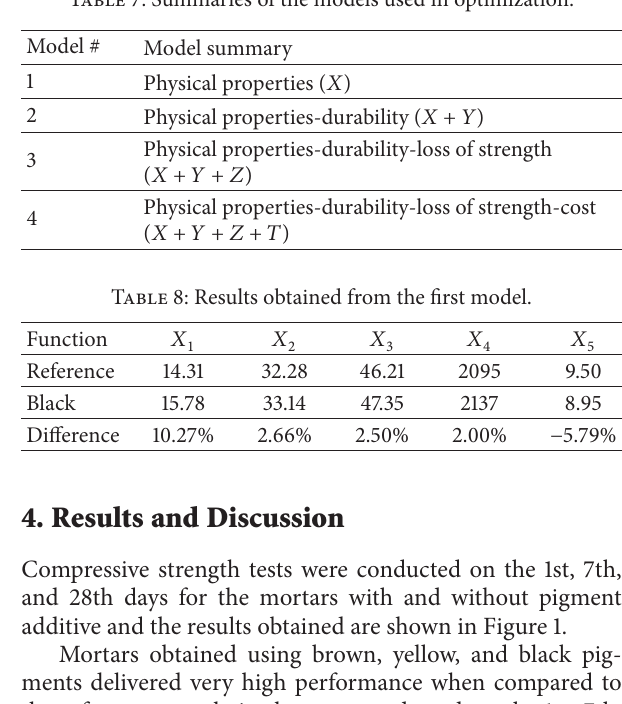
Table 7: Summaries of the models used in optimization.